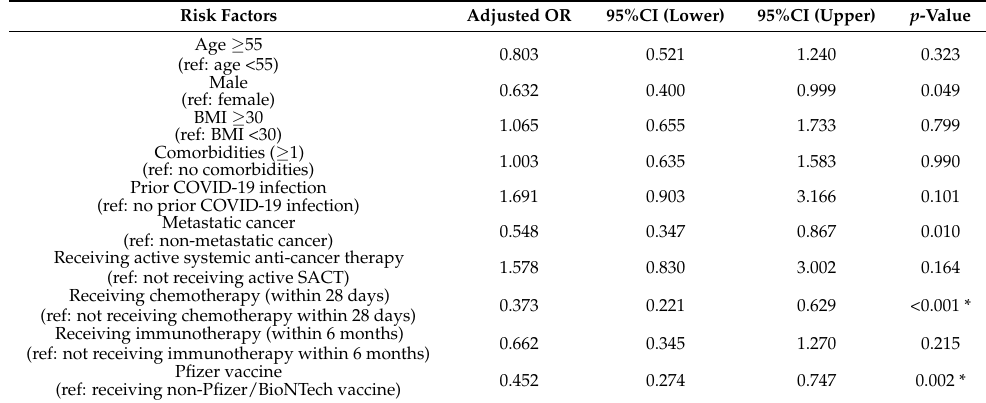
Table 7. Risk of any grade systemic vaccine-related adverse events ( n = 349). SACT, systemic anti-cancer